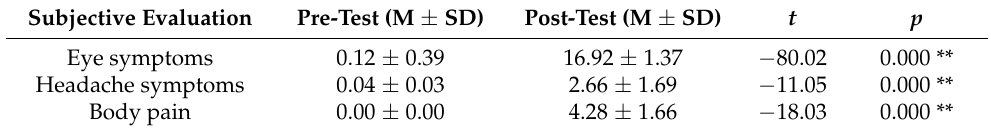
Table 1. Paired t -test for the subjective visual fatigue assessment. Subjective